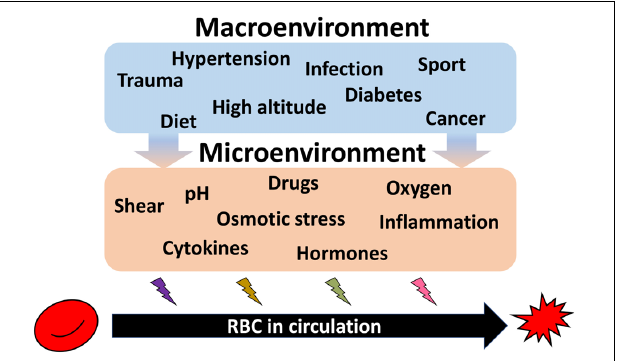
FIGURE 4 | Summary on the environmental causes imposing heterogeneity of circulating RBCs. Exposure of the organism to high altitude or practicing endurance sport as well as dietary preferences cause durable or acute impact on the RBC properties. Along with RBC diseases (anemia, polycythemia), pathologies such as hypertension, diabetes, infection, trauma, cancer, and further systemic diseases are influencing both erythropoietic niche and the circulating cells. All these macroenvironmental stresses translated into the changes in microenvironment for erythroid precursors and circulating RBCs. Shear, alterations in pH and oxygen levels, proinflammatory cytokines, and hormones, as well as drugs work to shape the features of each individual RBC resulting in an increase in the inter-cellular